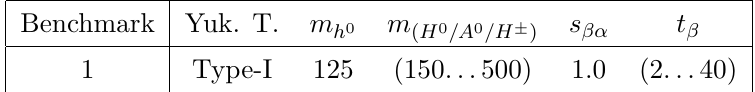
Table 1 . The range of the free parameters of the model, all masses are given in